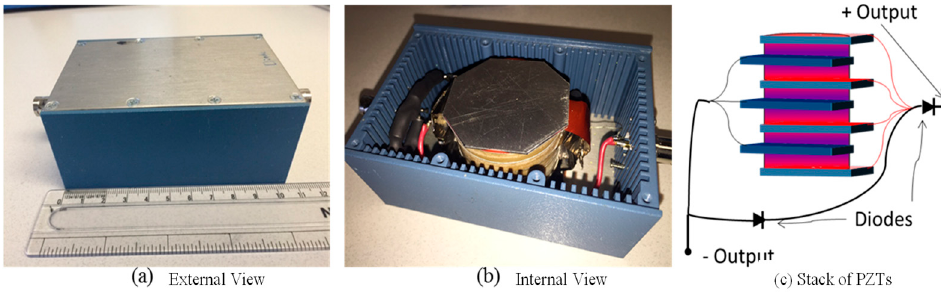
Figure 1. The HiSEC Prototype Module